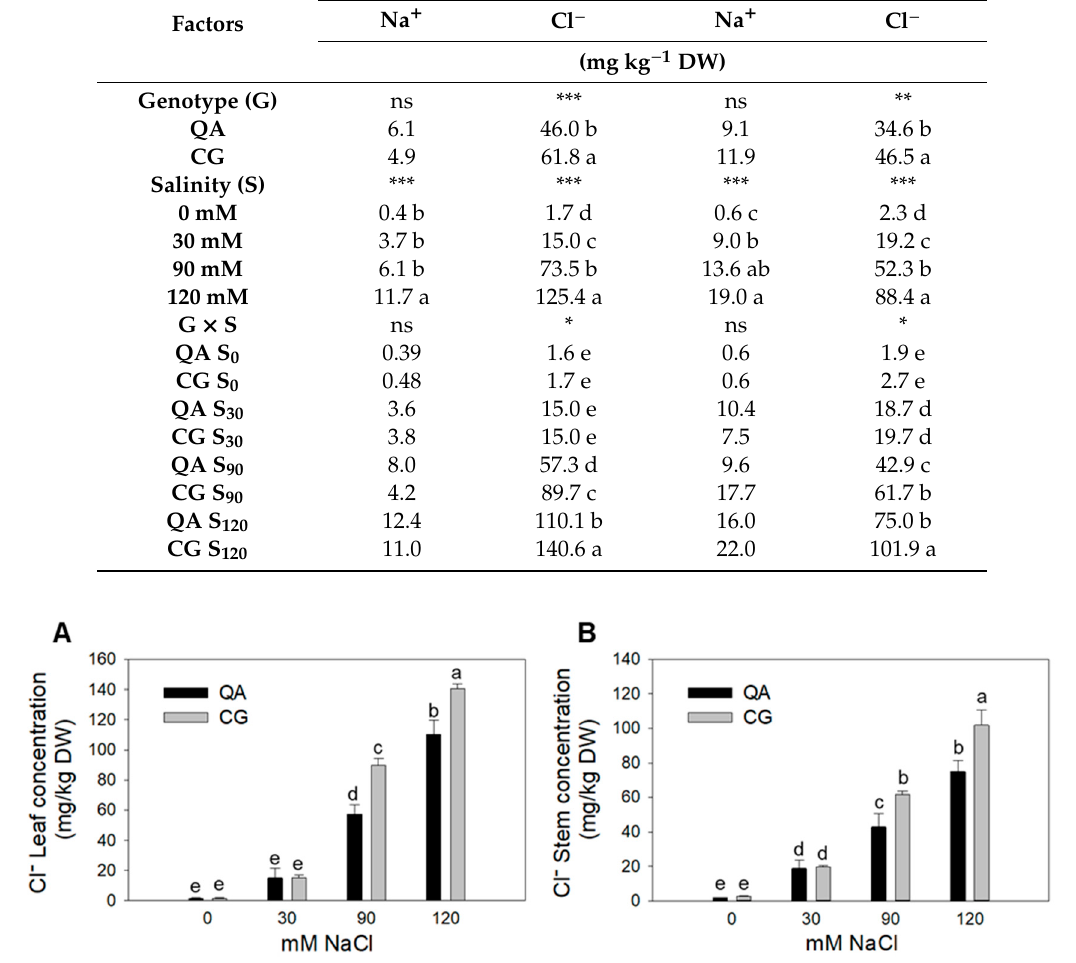
Figure 4. Chloride (mg/kg dry weight,DW) content in leaves ( A ) and stems ( B ) of the commercial cultivar (QA) and the landrace (CG) grown at control (0 mM), low salinity (30 mM), moderate salinity (90 mM) and high salinity (120 mM) at DAT 168. Error bars indicate standard error of the means. Means with the same letter are not significantly different according to Duncan’s post hoc test ( p < 0.05).